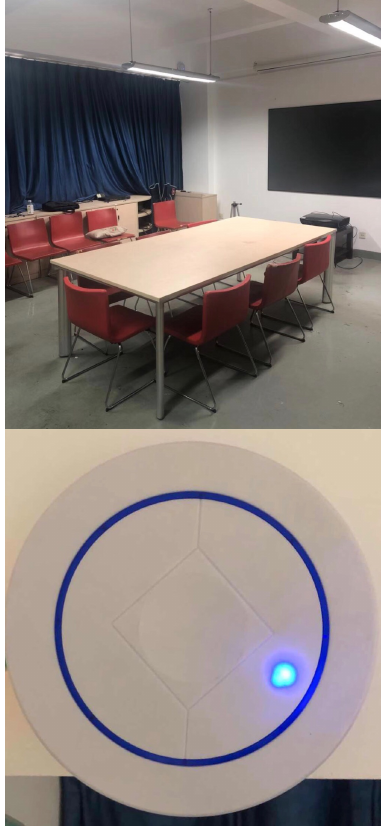
Figure 3. Picture of the experimental area and UWB base